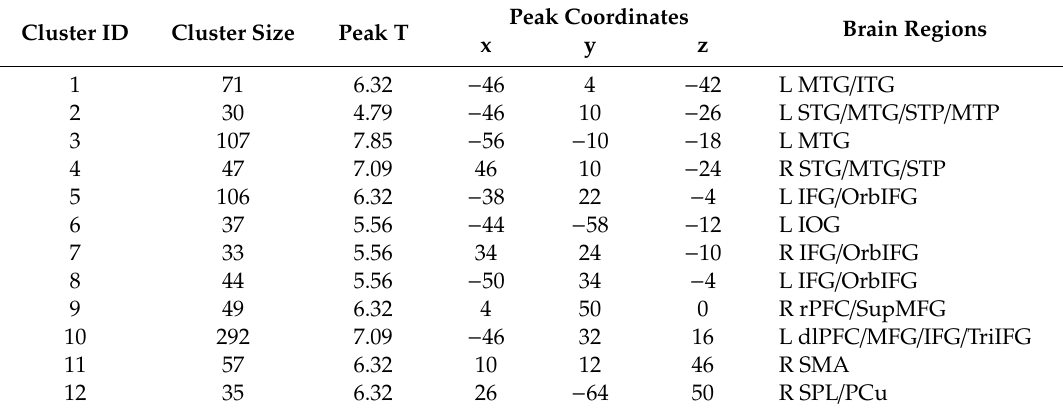
Table 1. Coordinates of dementia-associated surface regions identified from